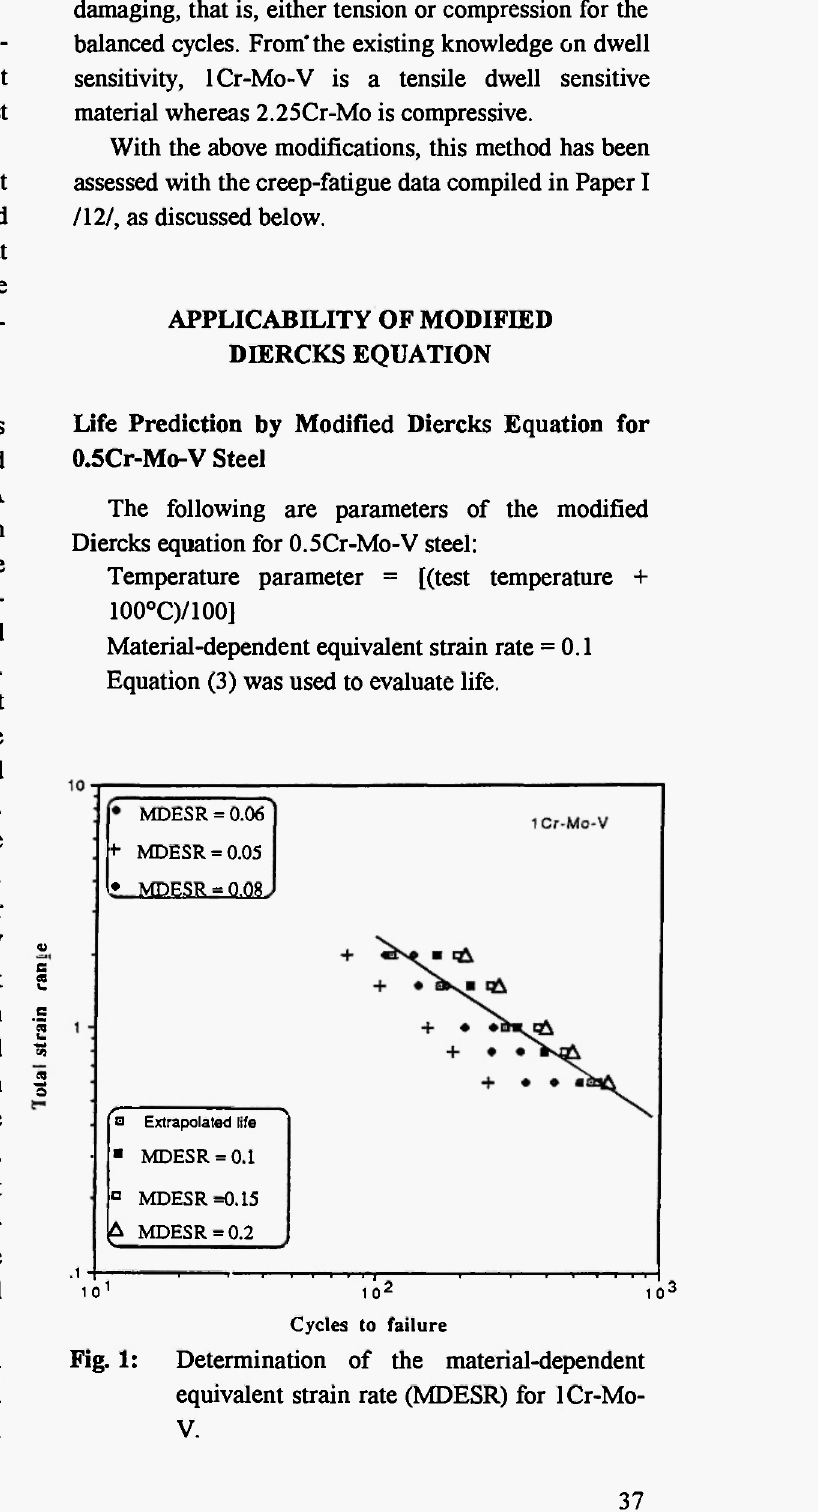
Fig. 1: Determination of the material-dependent equivalent strain rate (MDESR) for